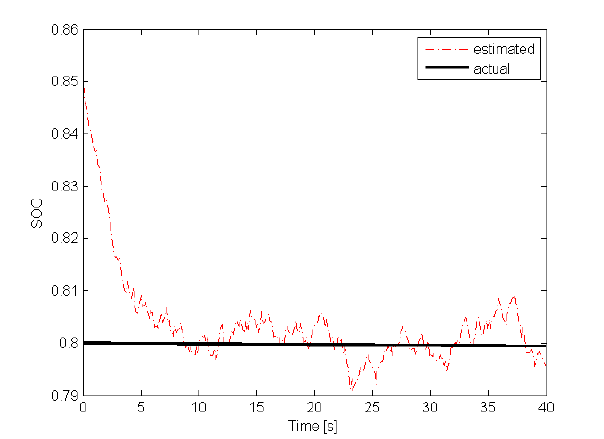
Figure 9. Function γ ( · ) .